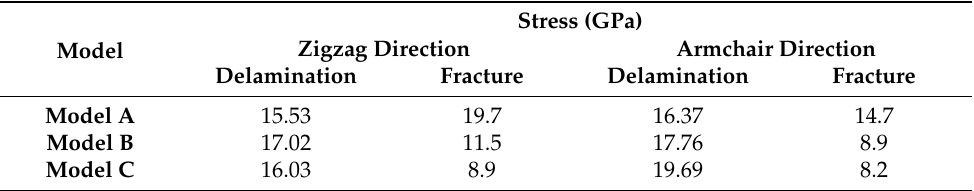
Table 2. The stress values at the time of delamination and the fracture stress in the armchair direction and the zigzag direction.